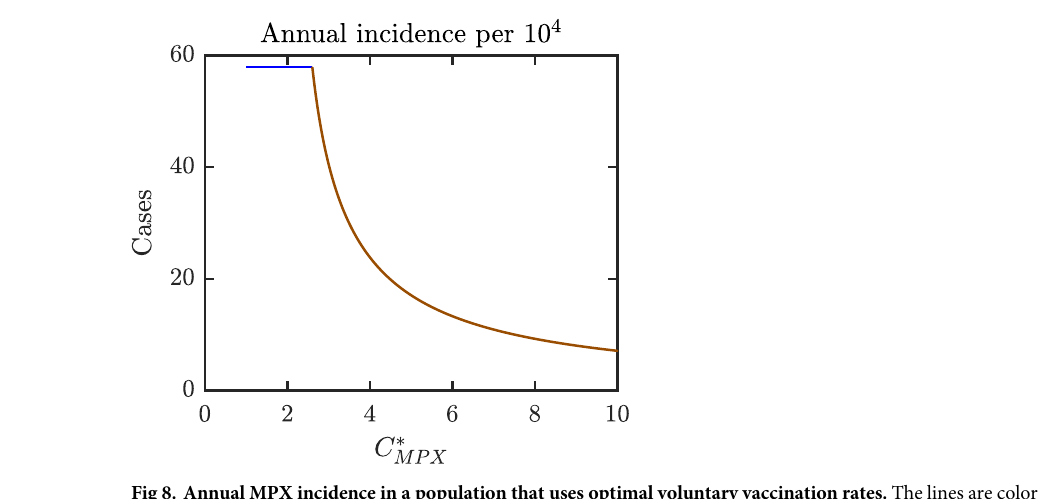
vary. Blue: 0 is the only NE and it is CSNE. Brown: positive ψ MPX